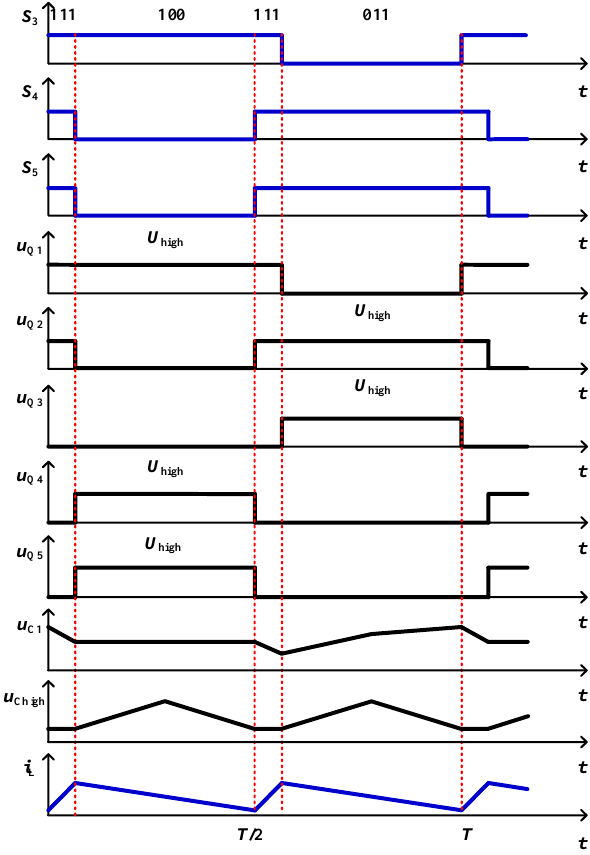
Figure 6. Typical waveforms of the proposed converter in the step-down mode.